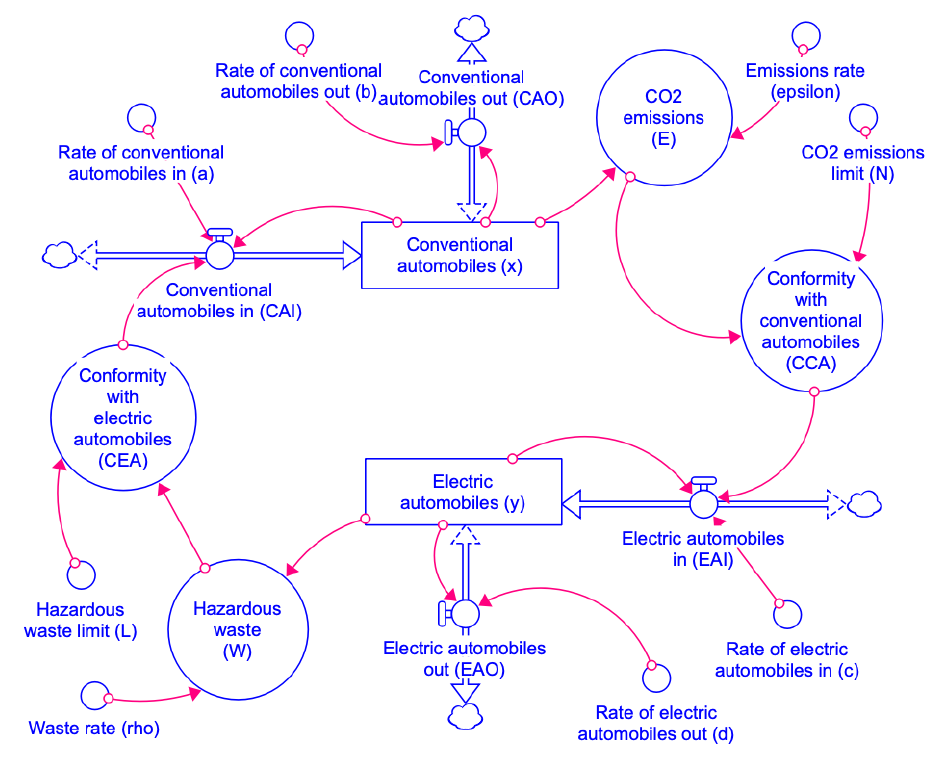
Figure 1. Stocks and Flows diagram of the automobile technology transition from environmen- tal